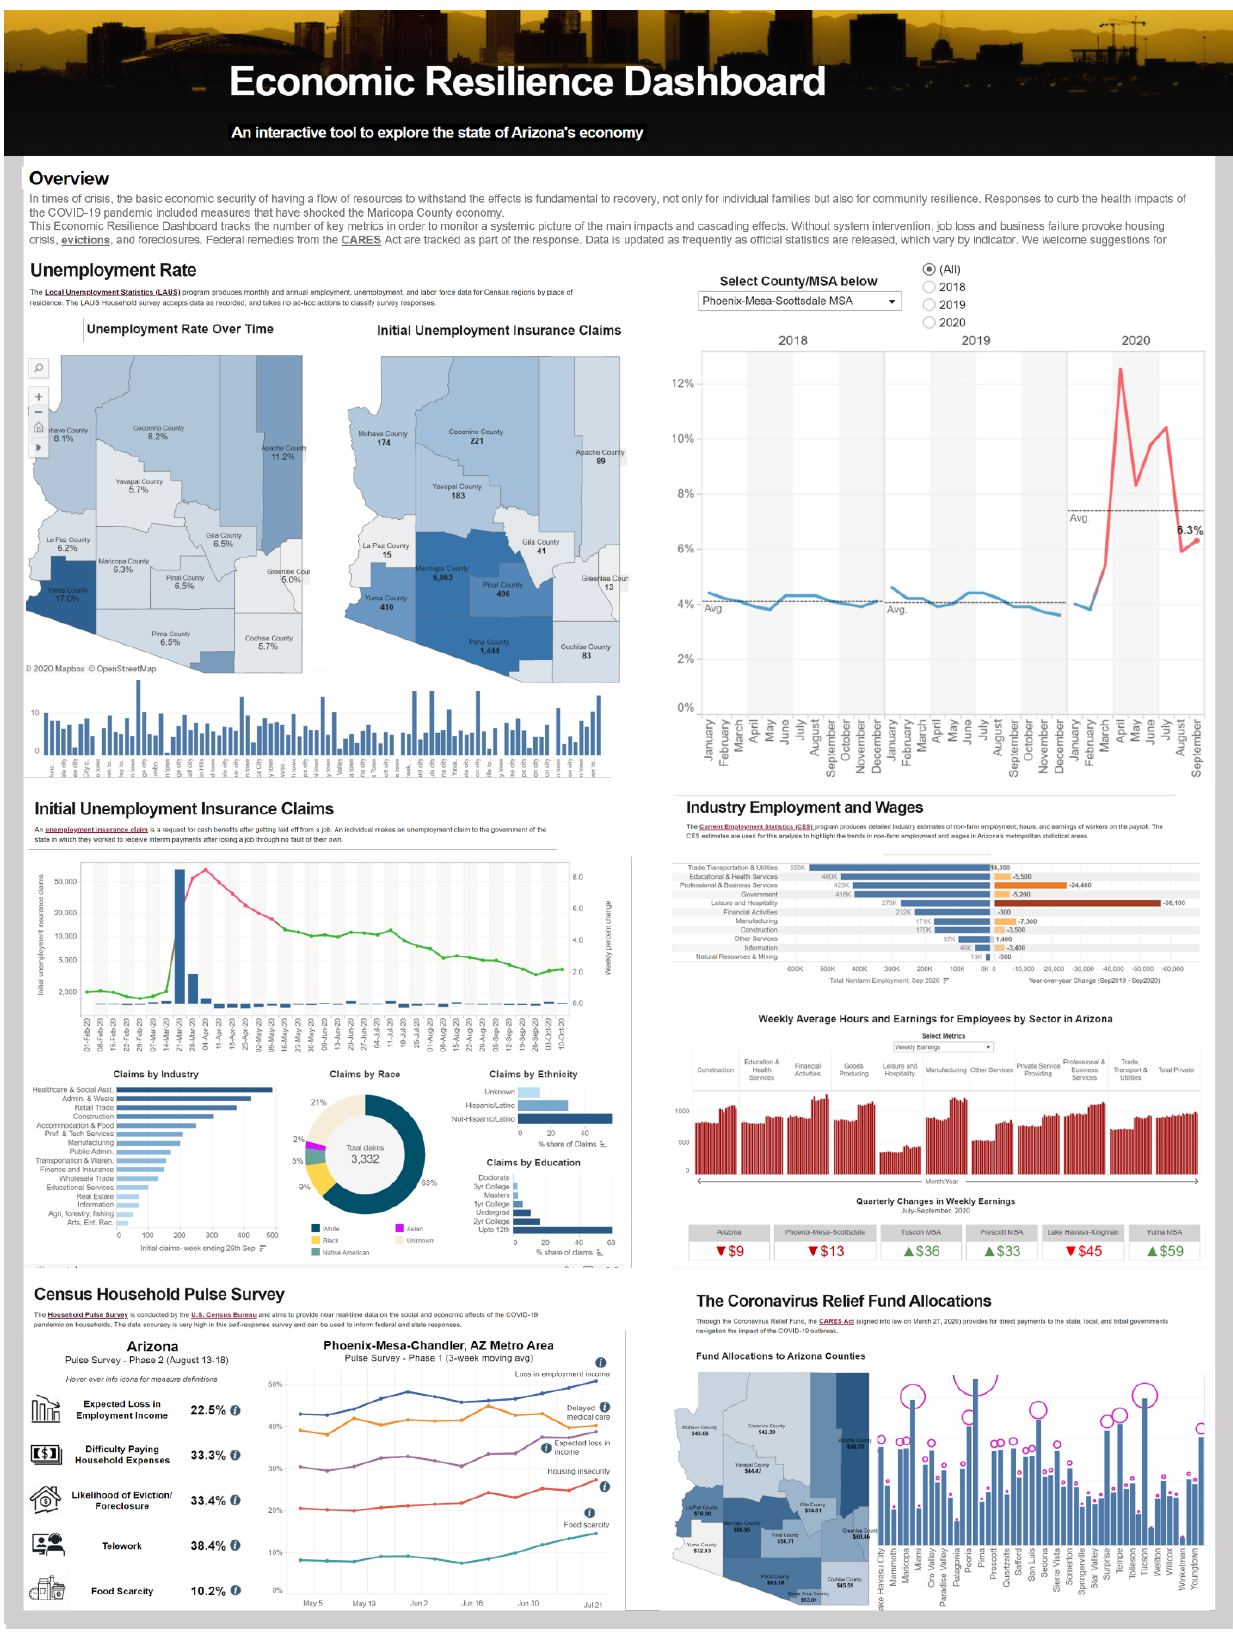
Figure 3. A screenshot of the Economic Resilience Dashboard (Source: https://resilience.asu.edu/economic-resilience-dashboard